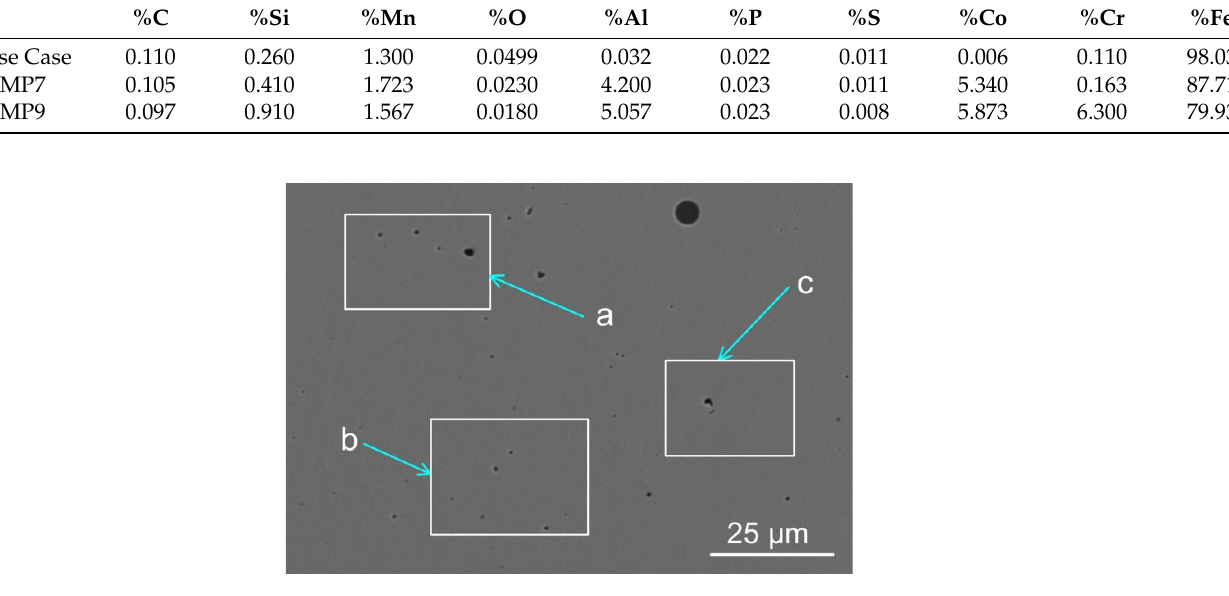
Figure 2. Scanning electron microscope micrograph of weld metal areas as marked a, b and c. (See Table 4 below, indicating the analyses per marked phase areas: a, b, and c) ( × 2460). Table 4. SEM-EDS analyses of marked areas in the MP9 weld metal as indicated in Figure 2